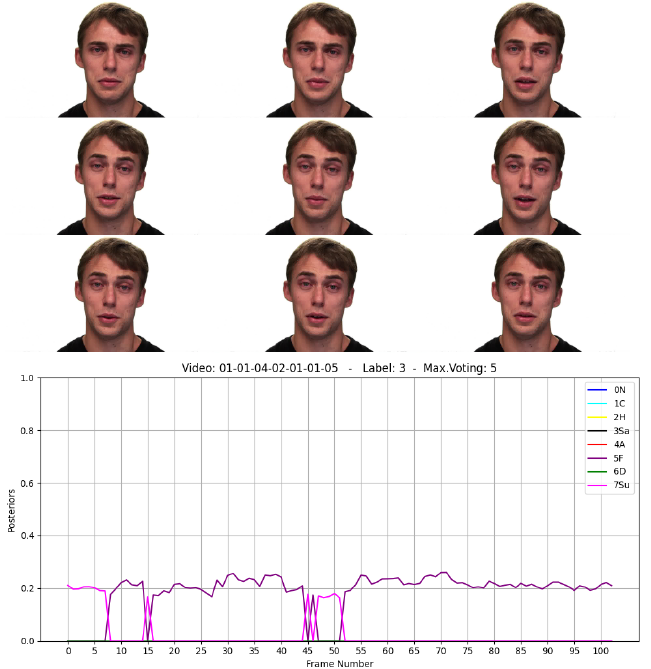
Figure A3. Example of frames from a video tagged as ‘Sad’ incorrectly predicted as ‘Fearful’. The whole video was incorrectly predicted as ‘Fearful’.